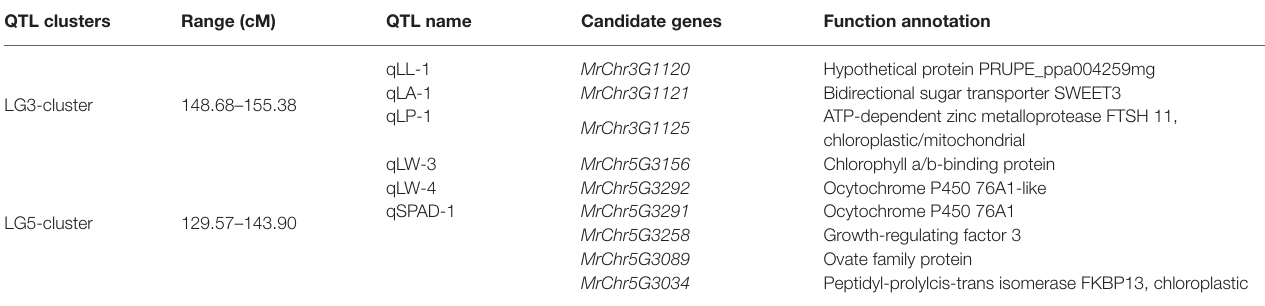
TABLE 5 | Quantitative trait loci clusters and candidate gene functional predictions. QTL clusters Range